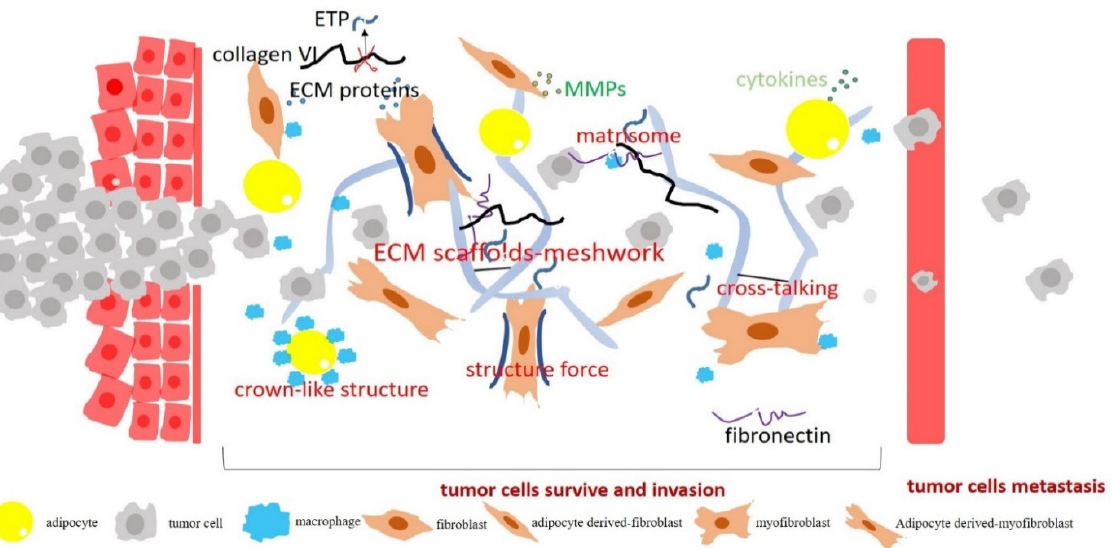
Figure 2. The role of obesity-associated fibrosis and ECM remodeling in cancer progression. During obesity development, adipocytes transform or de-differentiate into myofibroblast/fibroblast-like cells. These cells produce significant amounts of collagen VI, fibronectin, and MMPs. Obesity-associated fibrosis stimulates tumor cell growth, drives the transformation of premalignant cells, and induces tumor invasion and metastasis. Obesity-associated accumulation of myofibroblasts/fibroblasts and immune cells in adipose tissue releases cytokines and pro-inflammation factors, which further enhances cancer progression.